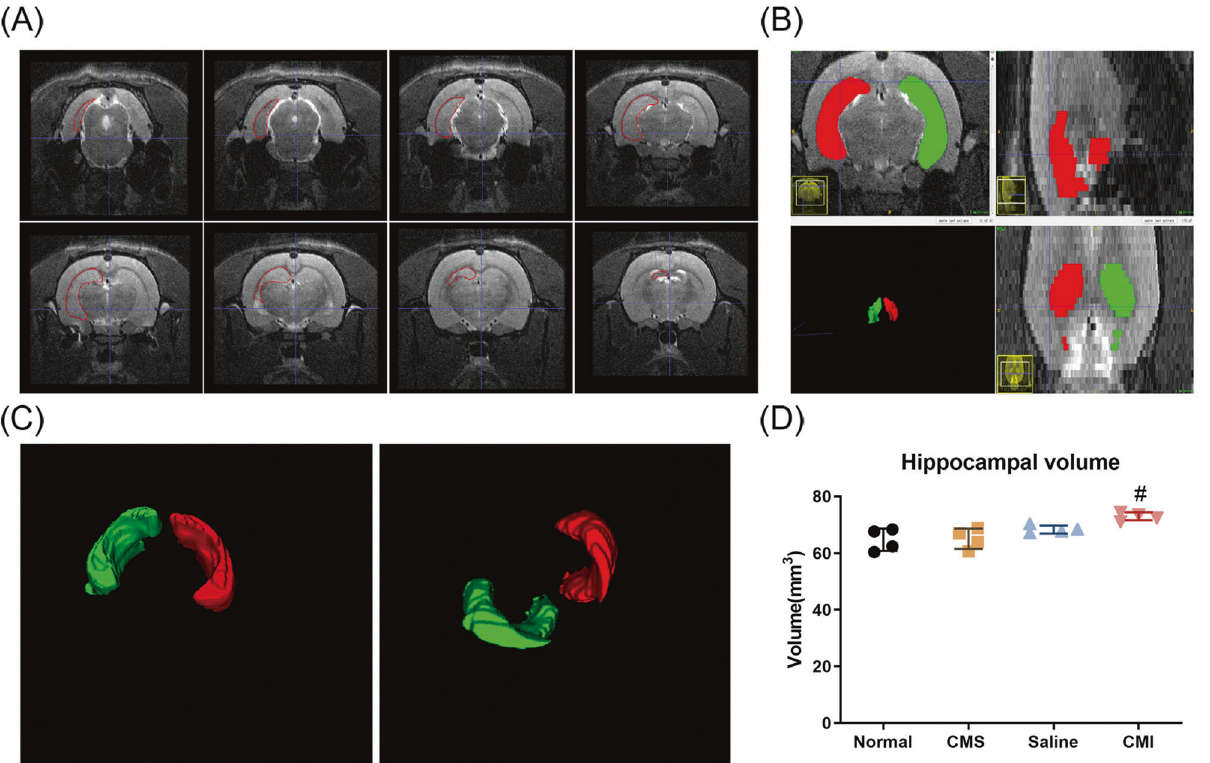
Fig. 4 Effects of CMS and clomipramine treatment on the volume of the hippocampus. A Representative T2-weighted MRI image of rats. The area outlined in red represents the hippocampus. B The distribution of the delineated hippocampus in three planes. Different colors represent the hippocampus on different sides. C The three-dimensional rendering of the delineated hippocampus. Different colors represent the hippocampus on different sides. D MRI analysis of the rats ’ hippocampi ( n = 4/group). All data are expressed as the mean ± SD. # p < 0.05, compared to saline-treated